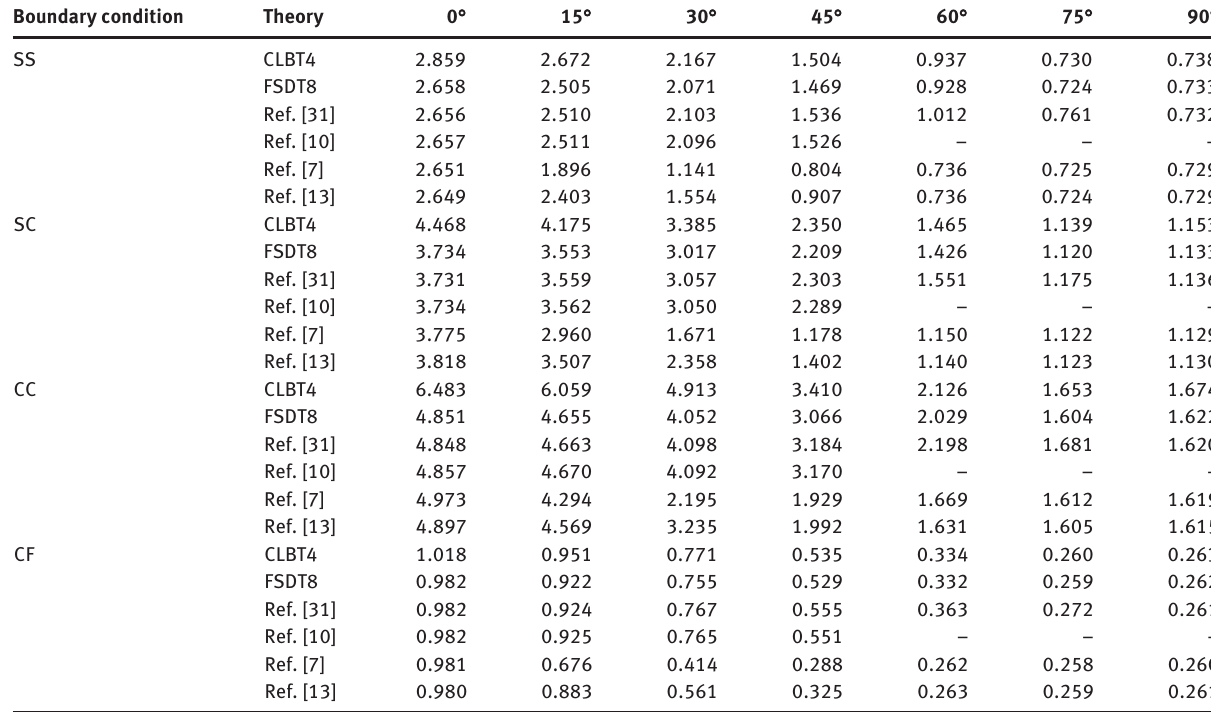
Table 1 Comparison of the non-dimensional natural frequencies of symmetric lay-up ( θ ° /- θ ° /- θ ° / θ ° ) composite beams with various bound- ary conditions and material